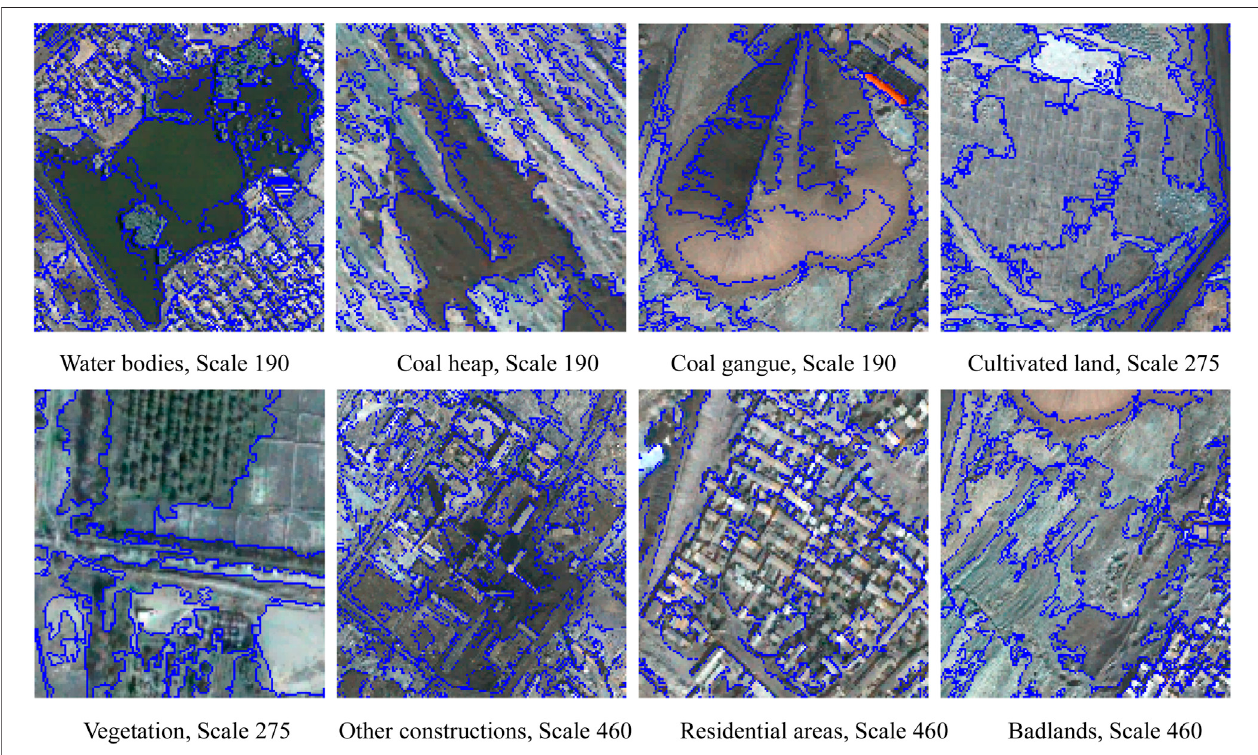
FIGURE 8 | Optimal segmentation scale of the objects in QuickBird image. Water bodies scale 190, coal heap scale 190, coal gangue scale 190, Cultivated land scale 275, vegetation scale 275, other construction scale 460, residential areas scale 460 and badlands scale 460.